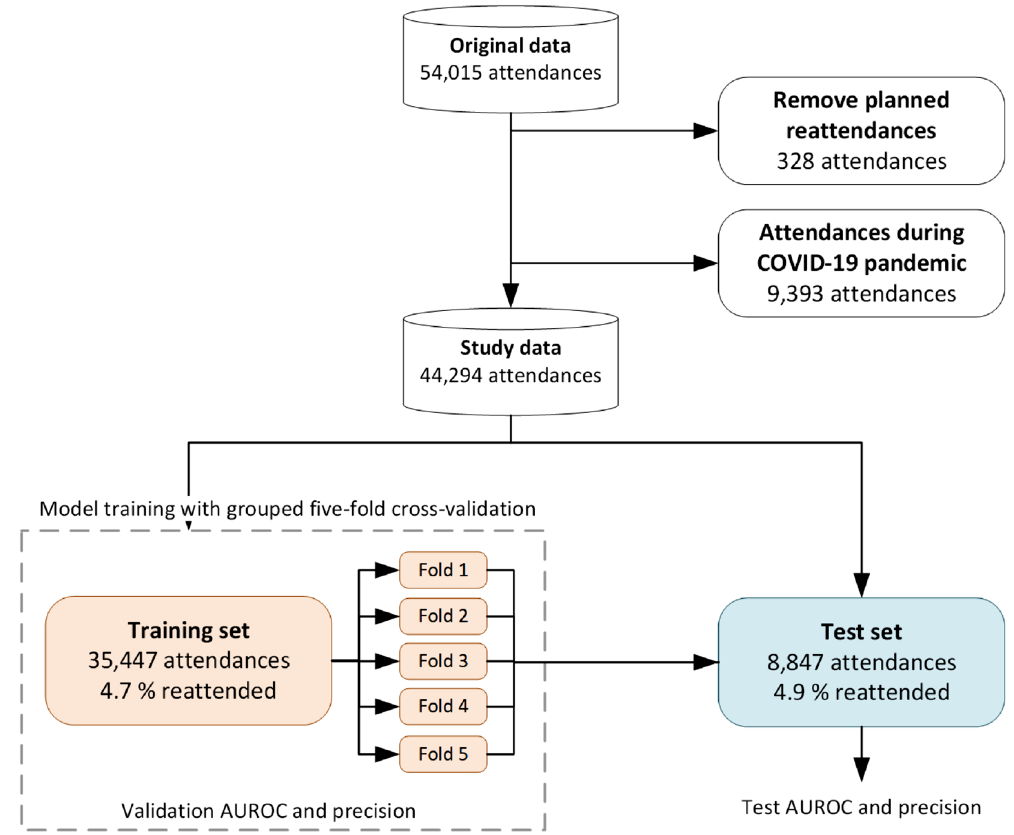
Figure 1. Partition of the study data into the training and hold-out test set. Attendances which resulted in planned reattendances (328 attendances) were removed. All attendances (9393 attendances) occurring after 01/02/2020 were also discarded to remove attendances which coincided with the COVID-19 pandemic. Reattendance rates (bottom row of rectangles representing training and test sets) display the observed 72-h reattendance rate for each cohort. Models were trained using (grouped) five-fold cross validation of the training set with patients in the train set not present in the validation set during the training phase. Model hyperparameters were selected such that the validation AUROC (mean out-of-fold AUROC across the five folds) was maximized. The final model was a mean ensemble of the five models (the average prediction of